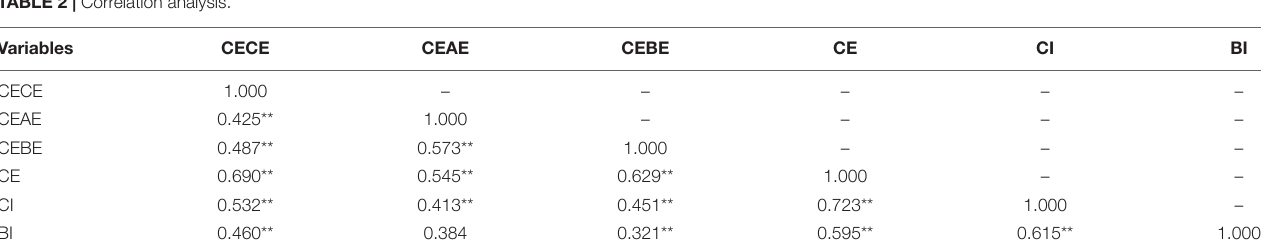
TABLE 2 | Correlation analysis.